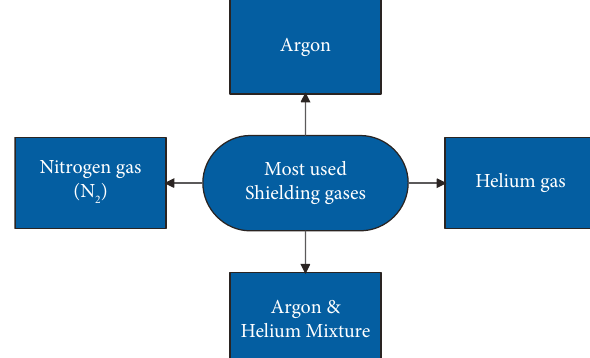
Figure 18: Frequently used shielding gases.